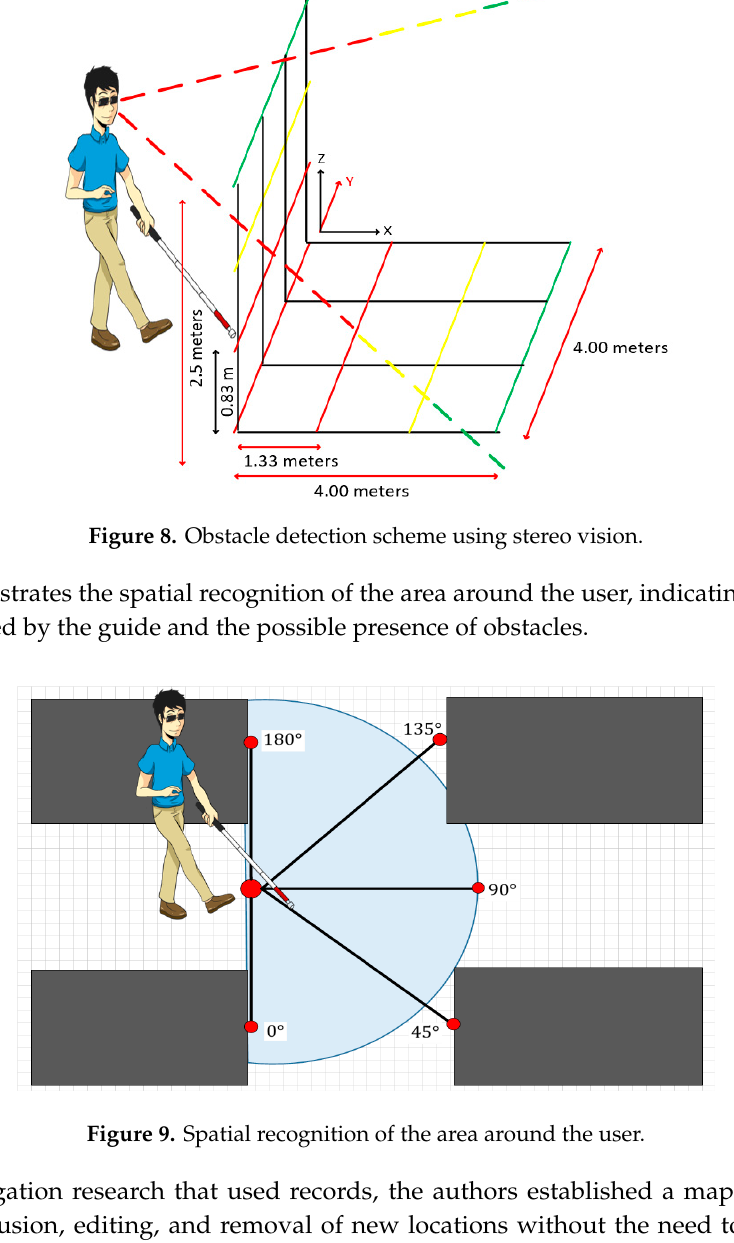
Figure 10. Indoor navigation system architecture.